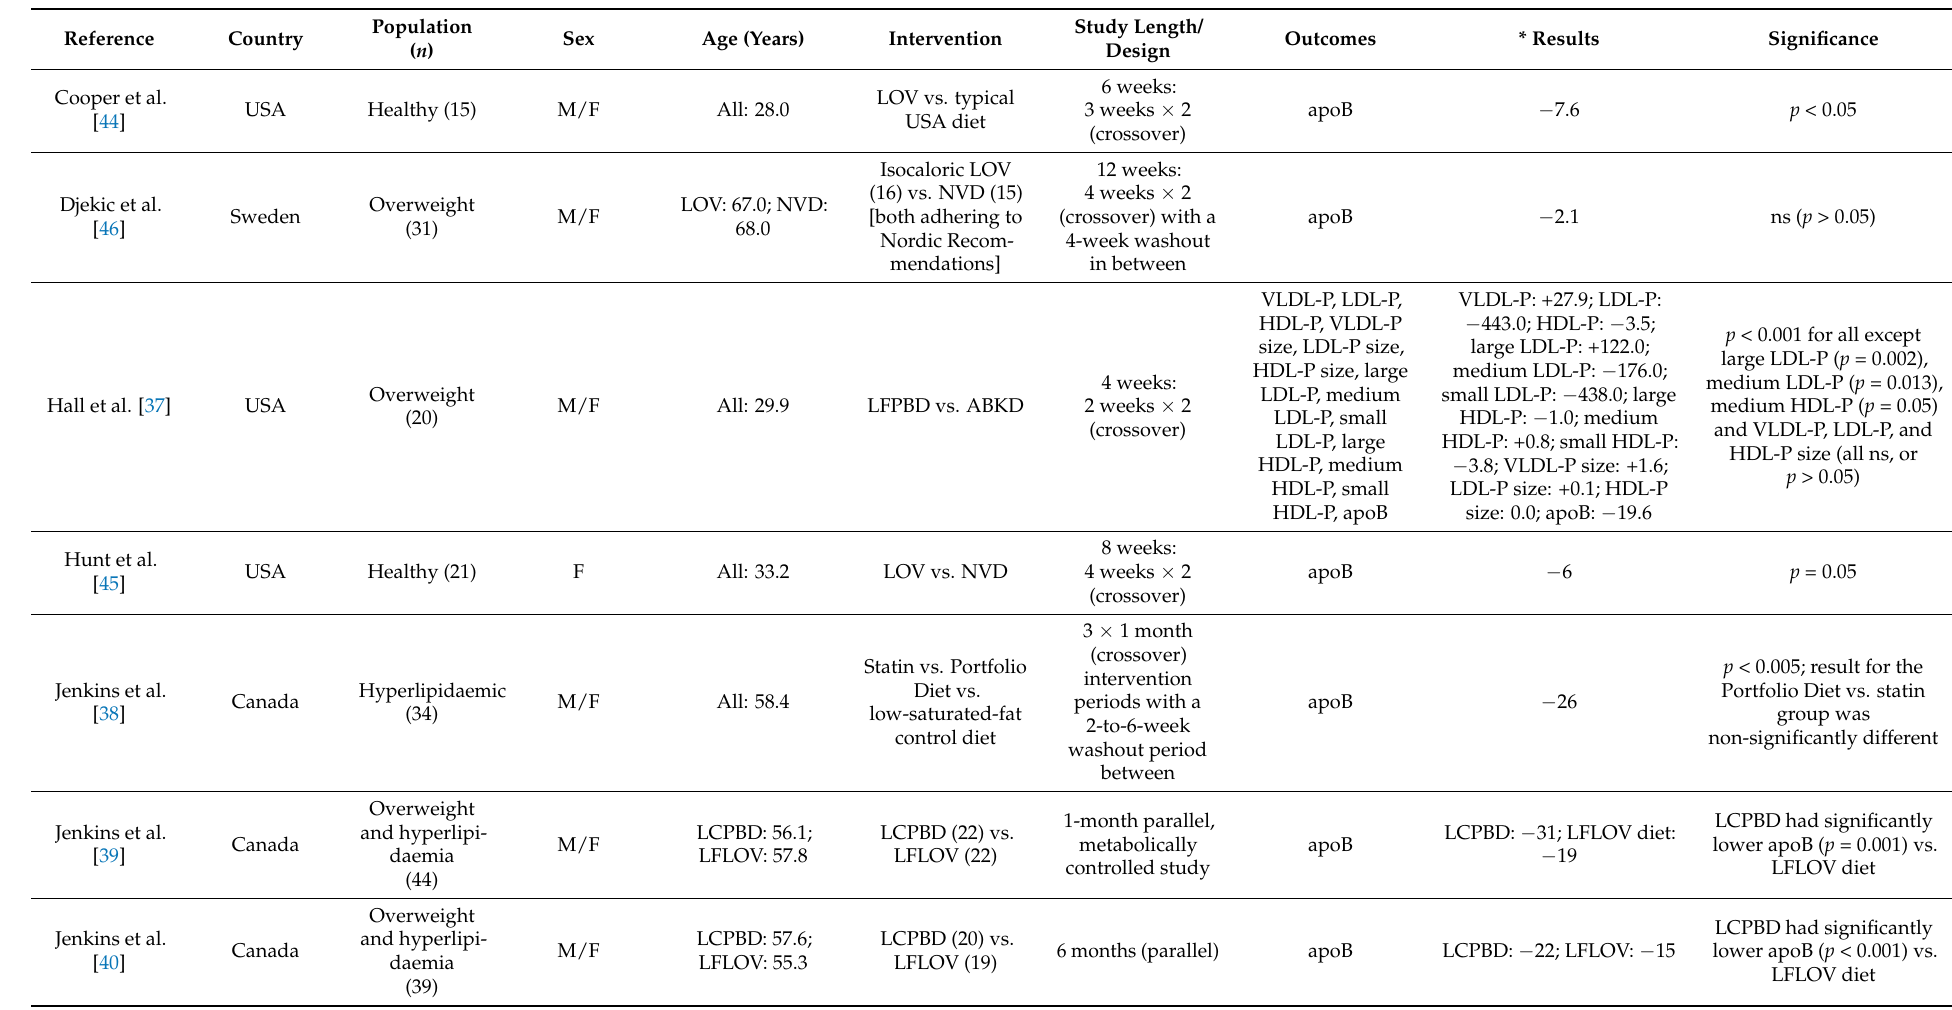
Table 5. Randomised Controlled Trials of Plant-Based Diets and Lipoprotein